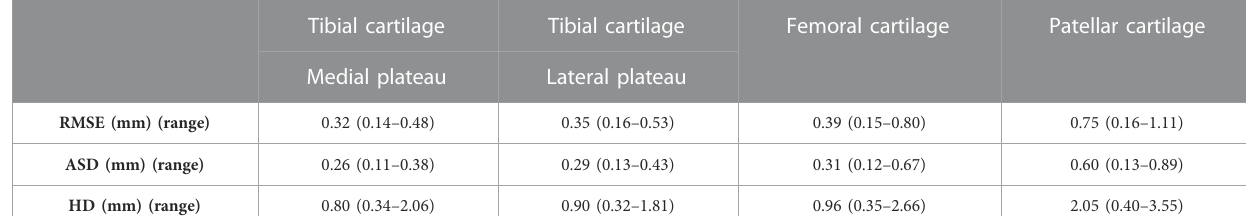
TABLE 2 Median RMSE, ASD and HD with range for tibial, femoral and patellar cartilage layer prediction. Tibial cartilage Tibial cartilage Femoral cartilage Patellar cartilage